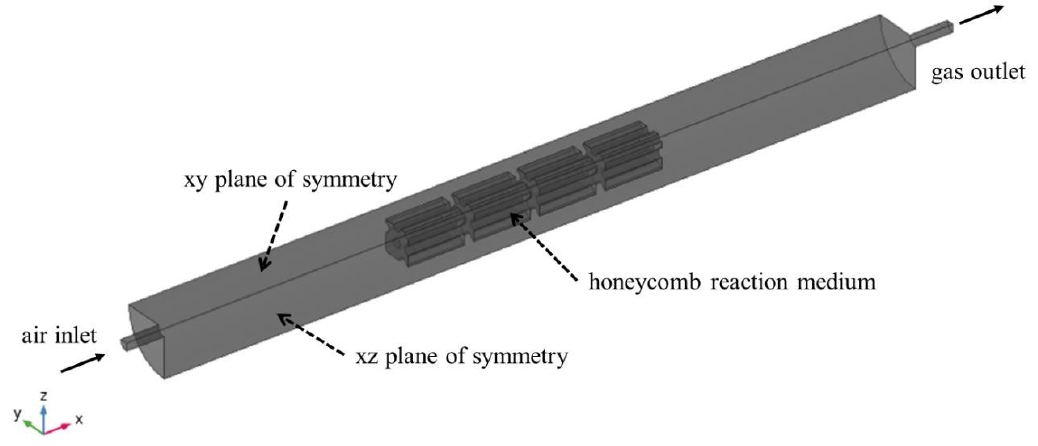
Figure 3. Geometric model of honeycomb-structured reactor.